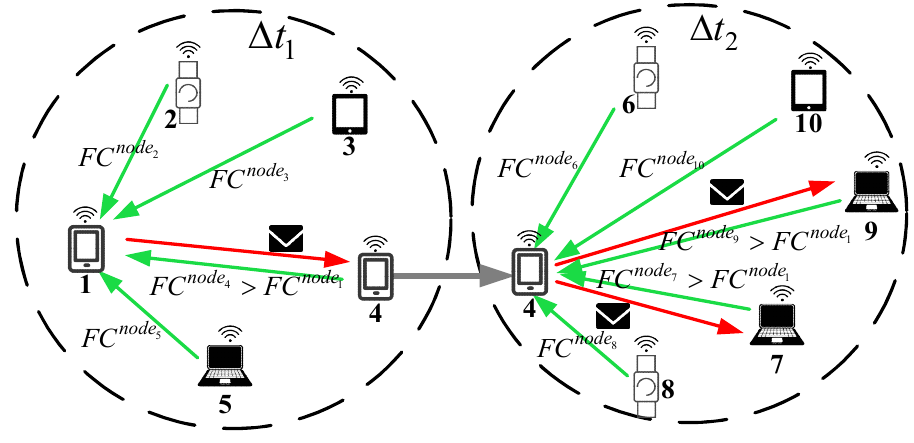
Figure 3. Data routing and forwarding process in two-hop feedback mechanism.